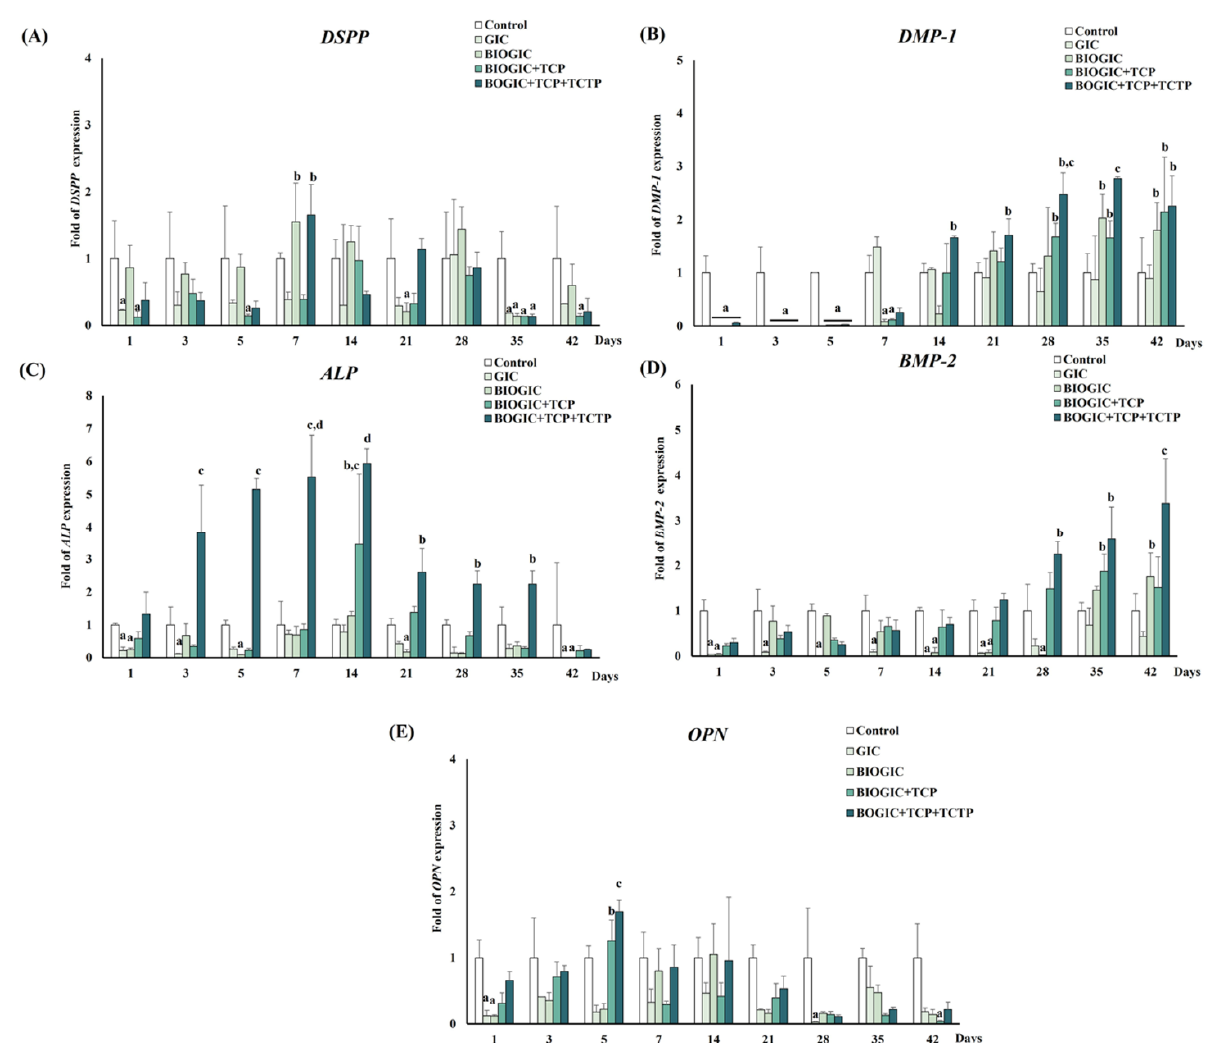
Figure 12. The quantification of the mRNA gene expression related to odontogenic/osteogenic differentiation in hDPSCs cultured on each type of GIC for 1, 3, 5, 7, 14, 21, 28, 35, and 42 days. ( A ) Dentin sialo phosphoprotein (DSPP), ( B ) dentin matrix protein 1 (DMP-1), ( C ) alkaline phosphatase (ALP), and ( D ) bone morphogenetic protein-2 (BMP-2), and ( E ) osteopontin (OPN). Data are represented as mean ± standard deviation (SD) of cell populations. Different lowercase letters represent significant difference at p < 0.05 ( n = 4) between different groups within each time period (one-way ANOVA with Tukey multiple comparison test).